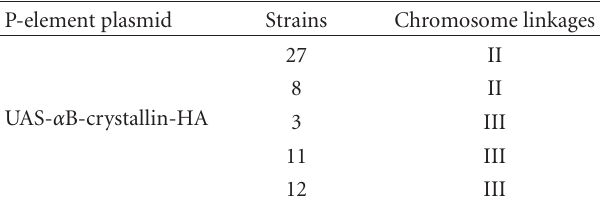
Table 1: Transgenic fly lines established in this study and their chro- mosome